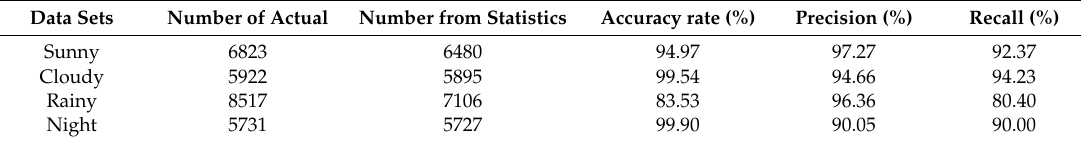
Table 4. YOLO-UA multi-environment traffic statistics.